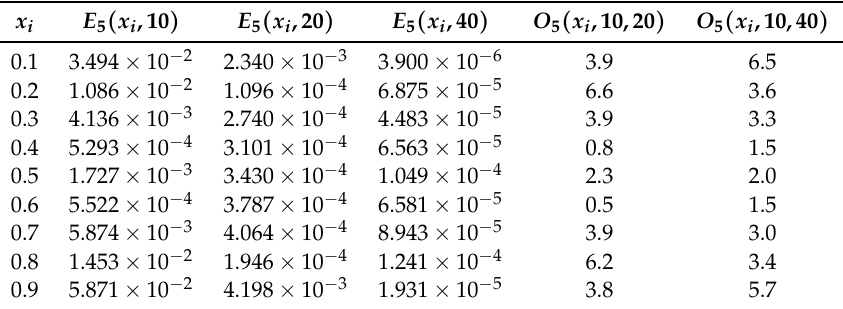
Table 7. The absolute errors of the fifth order derivatives of y 1 at the knots and the numerical convergence orders.